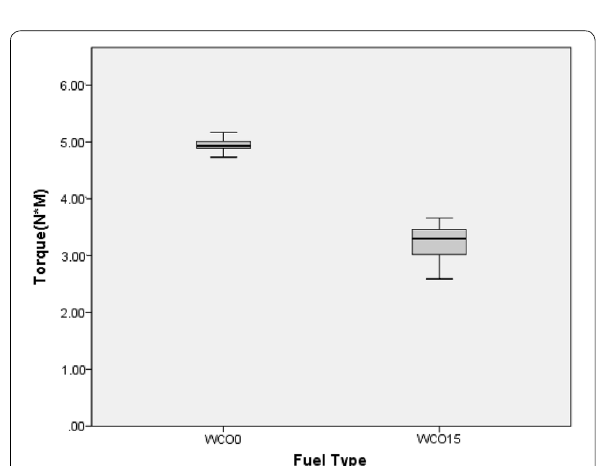
Fig. 9 Box plot diagrams of driving and exhaust characteristics [Torque (Unit: N *